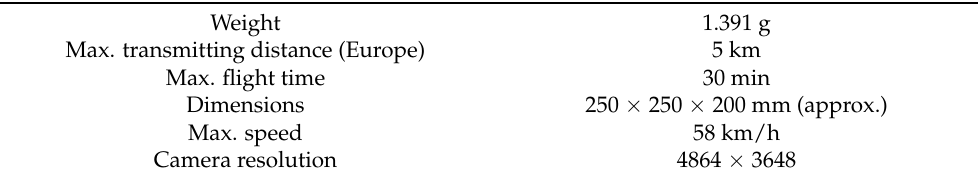
Table A6. Basic characteristics of DJI Phantom 4 RTK